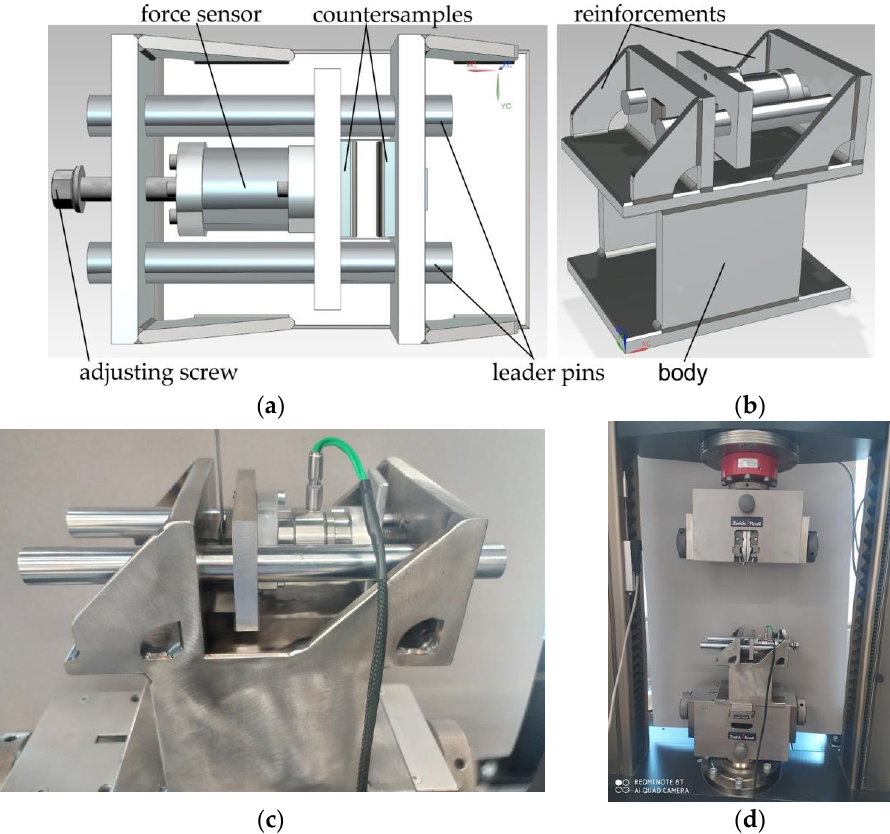
Figure 4. Geometric model of the friction tester in ( a ) top and ( b ) isometric views, ( c ) an actual photo and ( d ) friction tester mounted in Zwick/Roell Z100 testing machine. and ( d ) friction tester mounted in Zwick/Roell Z100 testing